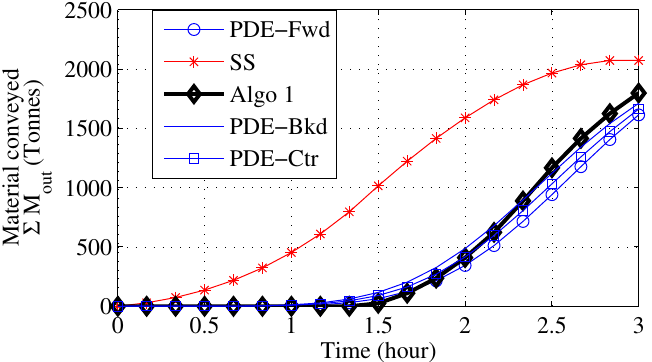
Figure 9. Calculated (Algorithm 1) and modeled amounts of material delivered by the conveyor after a given amount of